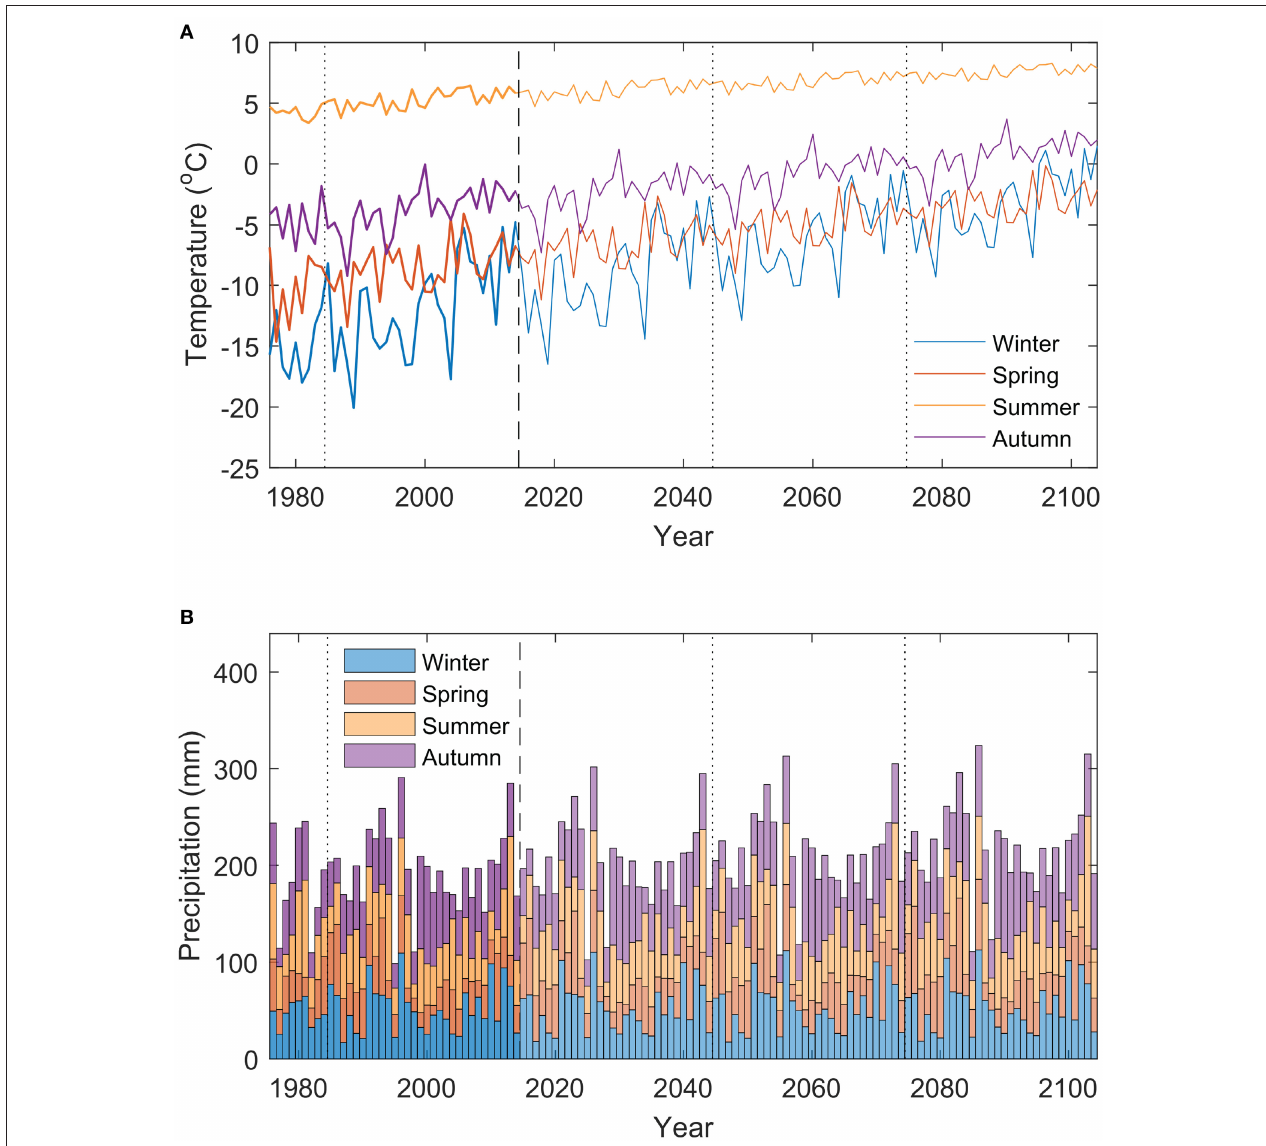
FIGURE 1 | Time-series of observed and projected winter (DJF), spring (MAM), summer (JJA) and autumn (SON) temperature (A) and precipitation (B) for the period